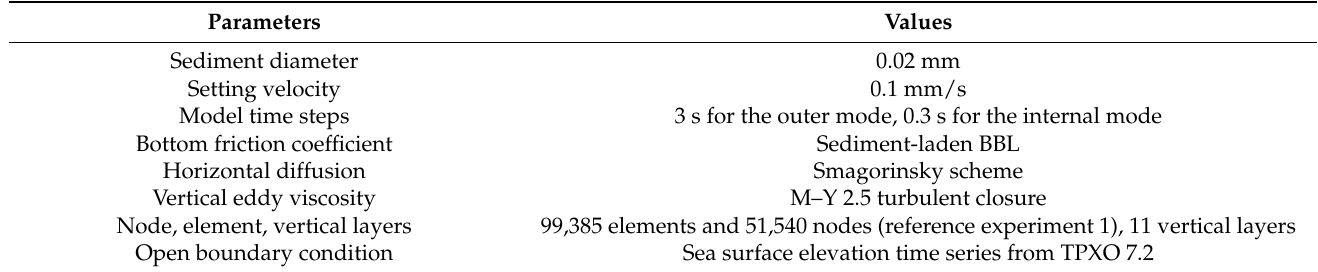
Figure 1. ( a ) Computational domain and locations of tide gauges along the Bohai coast, where six triangles represent six gauges, namely: DL (Dalian), LSG (Lvshungang), BYQ (Bayuquan), PL (Penglai), YT (Yantai) and WH (Weihai). ( b ) Locations of study sites near the Yellow River Estuary. Note: the black triangles indicate the locations of hydrosediment measurement stations (i.e., A1, A2, and A3); the red squares denote the location of the salinity measurement stations HH2; the black squares indicate the position of station S1 along the flow direction of the Yellow River into the open sea, whereas the black line indicates the position of section P1 which is along the flow direction of the Yellow River into the open sea. ( c ) A cross ‐ section diagram showing hypopycnal flow along the surface and hyperpycnal flow along the bottom of an estuary. Table 1. Key parameters of the